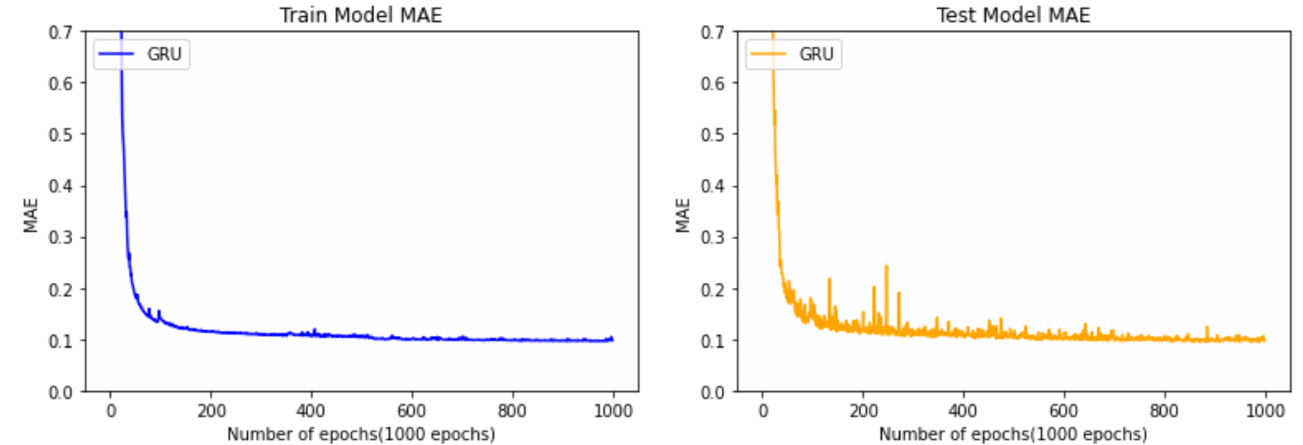
Figure 13. Comparison between train data and test data of the model using the GRU algorithm.